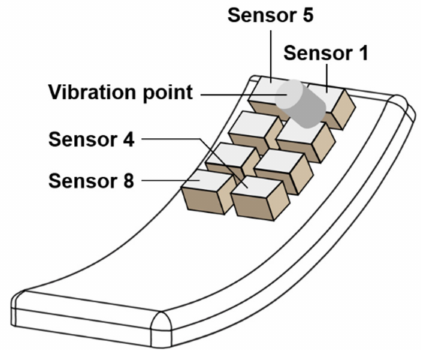
Figure 5. Schematic diagram of the MEMS sensor